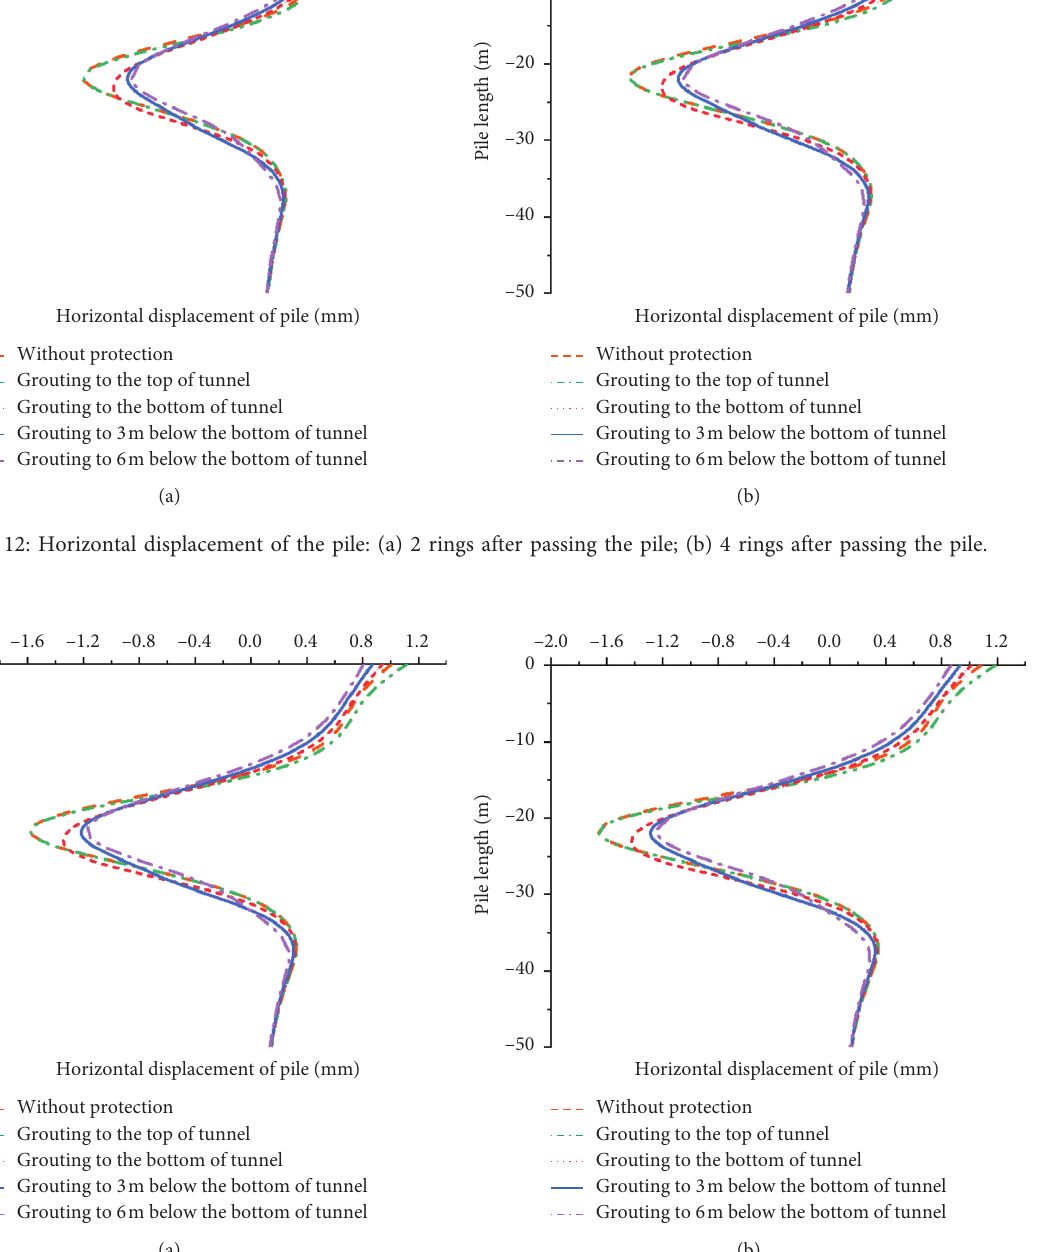
Figure 13: Horizontal displacement of the pile: (a) 6 rings after passing the pile; (b) 8 rings after passing the